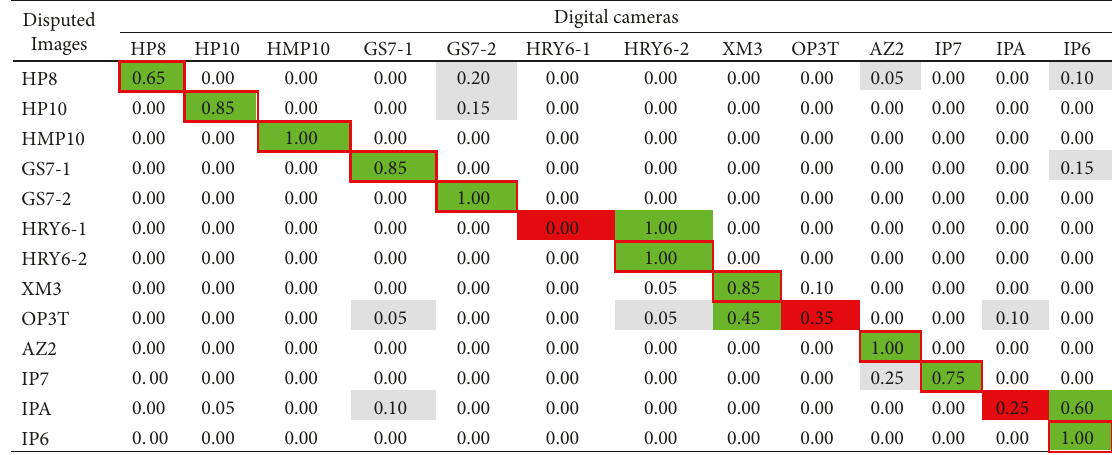
Table 6: Effectiveness of the proposed method when it is applied to the case study that includes natural images as disputed images and the PRNU is extracted from selected pixels and δ � 8 intensity levels.